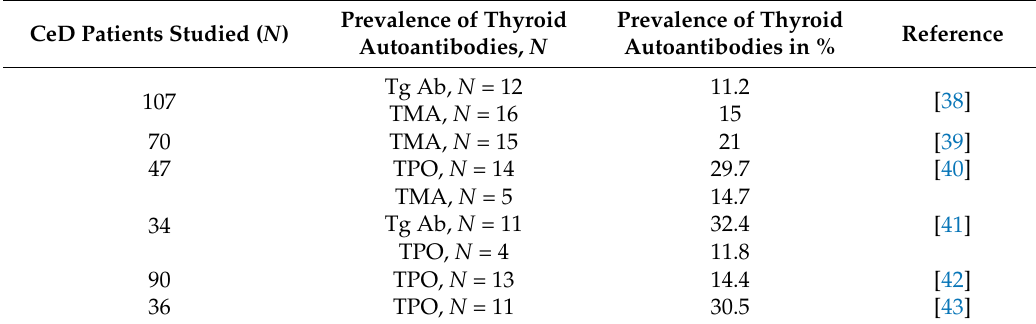
Table 2. Prevalence of autoimmune thyroid disease auto-antibodies in patients with celiac disease. CeD Patients Studied ( N